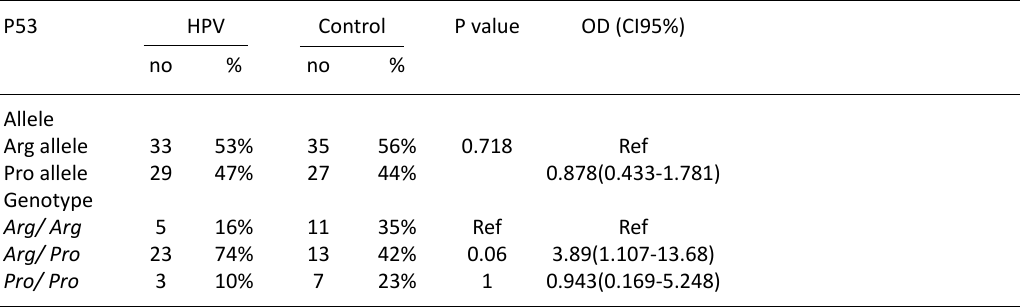
Table 2. Allele and genotype frequencies for P53 gene (Arg/Pro) polymorphisms amongst Papillomavirus infected patients and healthy group (uninfected controls) P53 HPV